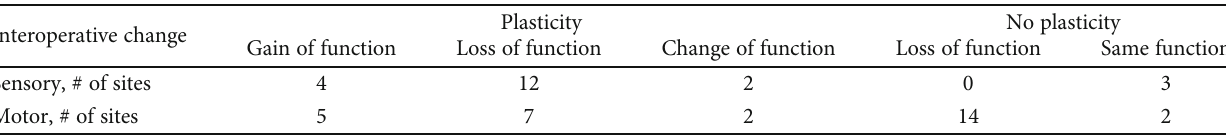
Table 2: Stimulation points ’ summary. At the time of the second operation, sites were classi fi ed as plastic if they gained function, lost cortical function without clinical de fi cit, or changed function. Nonplastic sites were those that lost cortical function with a clinical de fi cit or had the same function at the second operation.